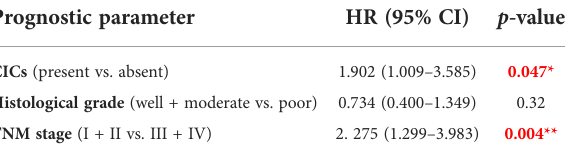
TABLE 3 Multivariate analysis of prognostic parameters for HCC. Prognostic